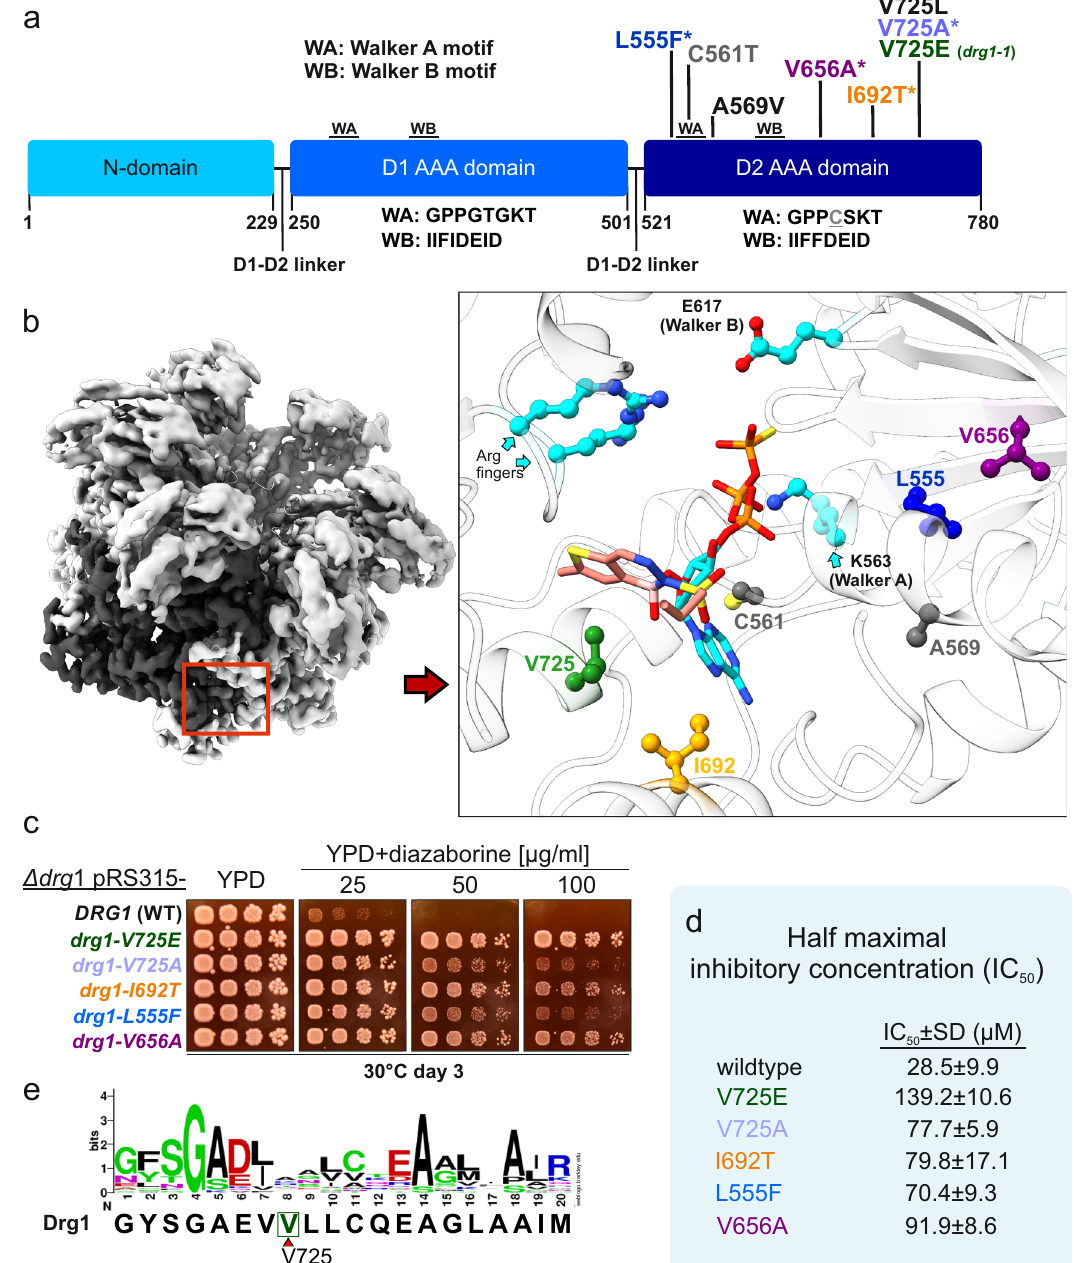
Fig. 4 Amino acid exchanges in the Drg1 D2 nucleotide-binding pocket cause resistance to diazaborine. a Domain organization of Drg1. Exchanges causing resistance to diazaborine are colored. Residues highlighted by (*) were identi fi ed in this study by random mutagenesis of the DRG1 gene. Additional exchanges were described previously 14,15,21 . b Magni fi ed Drg1 D2 binding pocket at the interface between two monomers. Important residues of the conserved AAA-binding pocket motifs are shown in cyan (Walker A: K563, Walker B: E617, arginine fi ngers R671 and R674). c Δ drg1 deletion strains expressing plasmid-borne mutated drg1 alleles were spotted on YPD agar plates containing 0 – 100 µ g/ml diazaborine. d Half-maximal inhibitory diazaborine concentration (MIC). Δ drg1 deletion strains expressing plasmid-borne mutated drg1 alleles were grown in YPD containing increasing concentrations of diazaborine. Maximal OD 600 values were plotted against the diazaborine concentration and the IC 50 was calculated using non-linear regression. Two biological replicates were each measured in duplicates ( n = 4). Means and standard error are shown. Source data are provided as a Source Data fi le. e Sequence conservation of the region around V725 critical for diazaborine susceptibility compared to yeast AAA-ATPases exhibiting signi fi cant homology to Drg1. In addition, the human Drg1 orthologue SPATA5, the human Cdc48 orthologue p97 as well as the yeast dynein-like AAA-ATPase Mdn1 were included. The complete sequence alignment of the Drg1 D2 domain and its closest relatives is provided in Supplementary Fig.